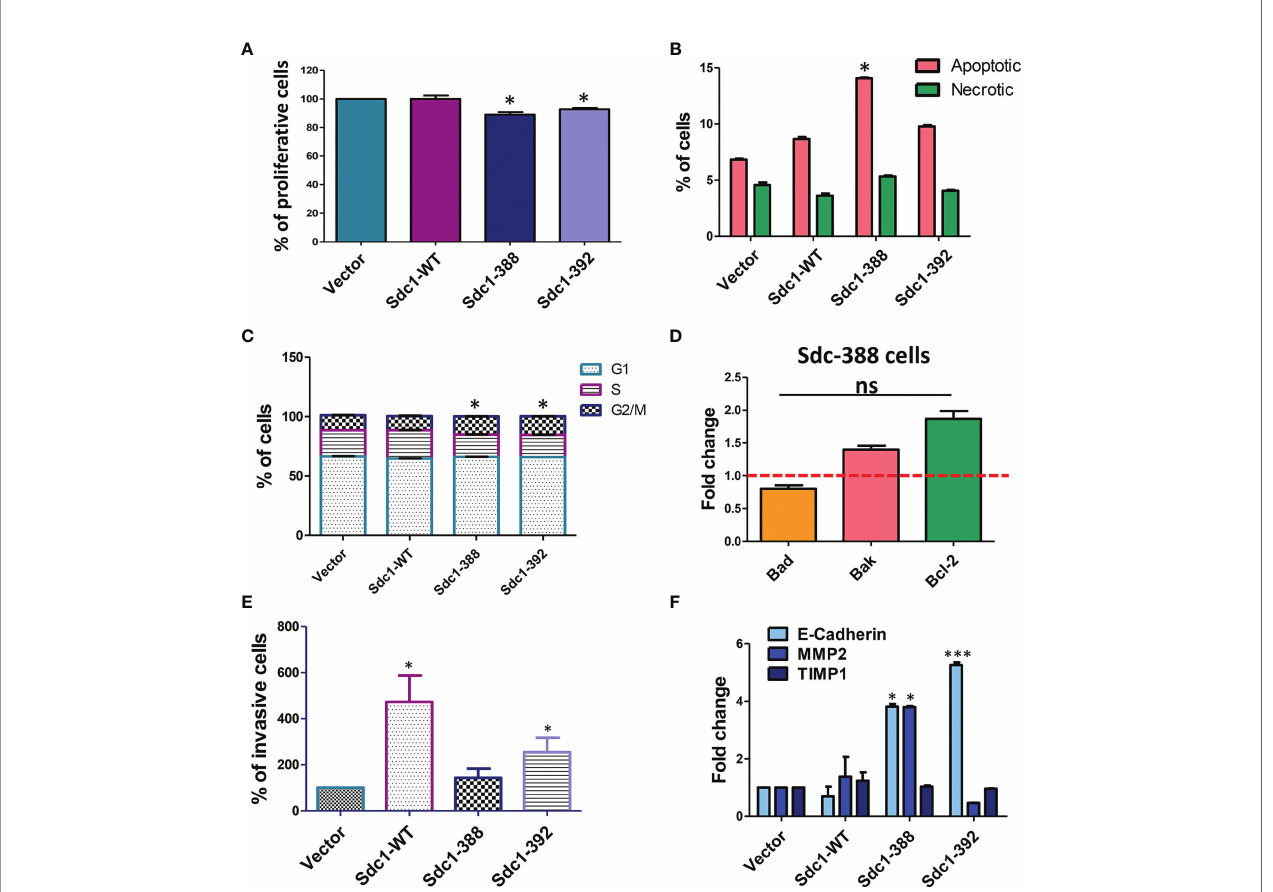
FIGURE 3 | Role for soluble and membrane bound forms of Sdc-1 in HeLa cell proliferation, cell cycle progression, apoptosis and invasion. (A) Differential effect of membrane-bound and soluble Sdc-1 on breast cancer cell proliferation. Control vector-transfected HeLa and HeLa cells stably overexpressing WT (Sdc1-WT), constitutively membrane-bound (Sdc1-388) or the soluble ectodomain (Sdc1-392) of Sdc1 were subjected to an Alamar Blue cell proliferation assay * P <0.05 (One- way ANOVA with Dunn ’ s post hoc test) for Sdc1-388 compared to vector control and Sdc1-392 compared to vector control n ≥ 3, error bars = SEM. Changes in apoptosis (B) and cell cycle progression (C) after the stable transfection of HeLa cells as quanti fi ed by using Annexin V/propidium iodide (B) and by DNA staining (C) and followed by fl ow cytometry. * P <0.05 (One-way ANOVA with Dunn ’ s post hoc test) for Sdc1-388 compared to vector control, and Sdc1-392 compared to vector control, n ≥ 3, error bars = SEM. (D) quantitative Real-Time PCR of the expression of the apoptosis markers Bad, Bak and Bcl-2 in the HeLa Sdc1-388 transfected cells. Data are expressed as fold change versus control vector-transfected cells. ns, no signi fi cant p value for all group comparisons (one-way ANOVA with Dunn ’ s post hoc test). n ≥ 3, error bars = SEM. (E) Stably transfected HeLa cells were subjected to a matrigel invasion assay. Quanti fi cation of invasive cells relative to control vector-transfected cells. *p <0.05 Sdc1-WT compared to vectror controls and SDc1-392 compared to vector controls, (one-way ANOVA with Dunn ’ s post hoc test), n ≥ 4, error bars = SEM. (F) quantitative RT-PCR analysis of E-cadherin, MMP2 and TIMP1 compared with vector controls. *p <0.05, MMP2 Sdc1-388 compared to vector controls, E-cadherin Sdc1-388 compared to vector controls, ***p <0.001, E-cadherin Sdc1-392 compared to vector controls (one- way ANOVA with Dunn ’ s post hoc test), n ≥ 3, error bars =